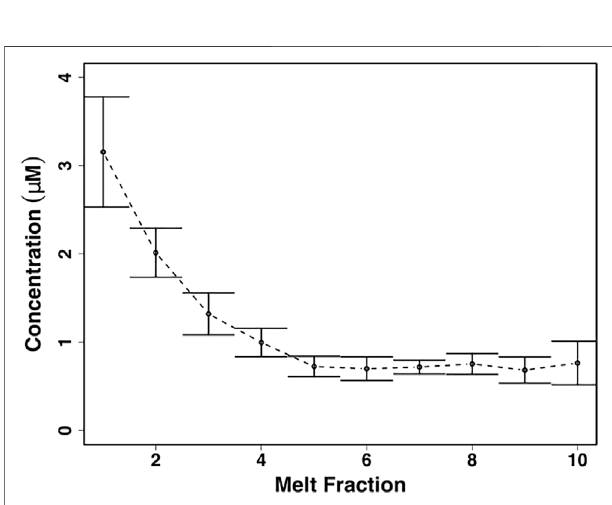
FIGURE5| Mean±SEnitrate(NO 3 − )concentrationsfromhomogenized snow pack sections in crude laboratory melt experiment ( n = 3) ( Figure 2C ).